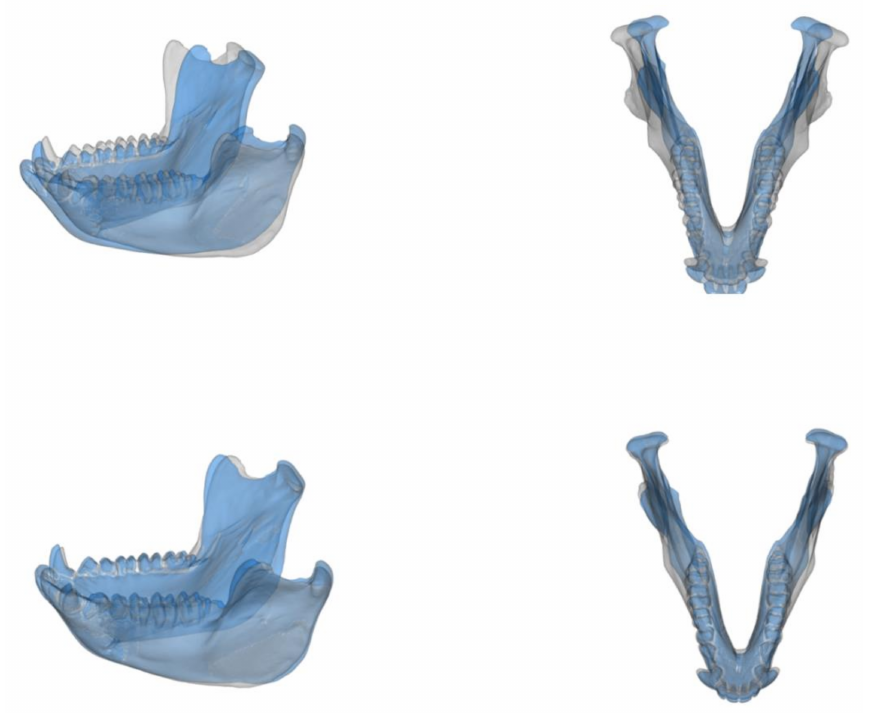
Figure 3. Surface warpings of the extremes of PC1 ( top ) and PC2 ( below ) of the symmetric PCA. The grey surface indicates minimum (negative) values while the blue surface indicates maximum (positive) values along the PCA